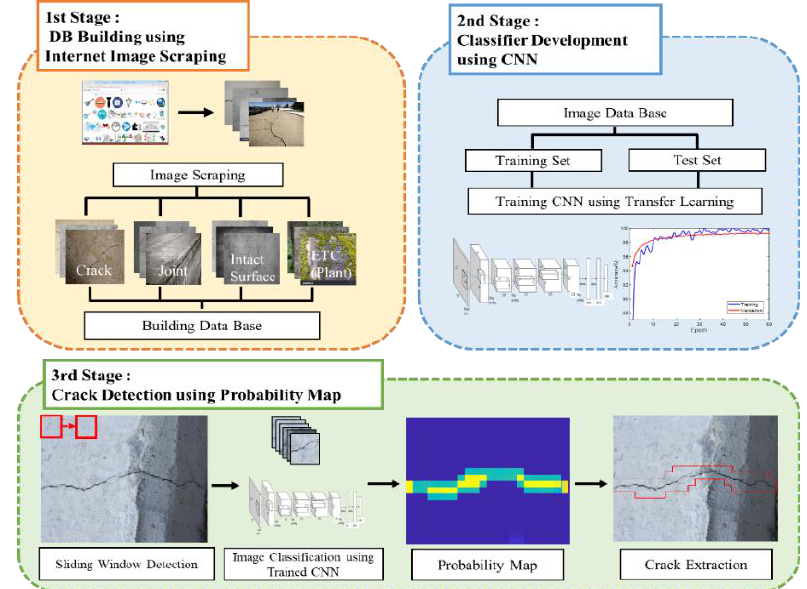
Figure 1. Overall framework of the proposed method.